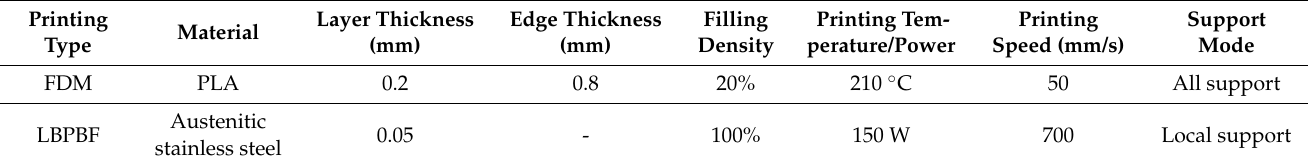
Table 2. Summary of the additive manufacturing